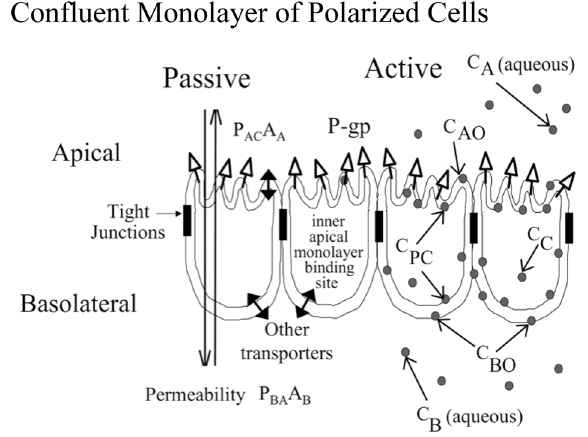
Figure 1. Model of a confluent cell monolayer, with the apical membrane on top and the basolateral membrane below, where it binds to the polycarbonate insert. Passive permeability occurs in both directions. P-gp expressed on the apical membrane transports substrate from the inner apical membrane monolayer into the apical chamber. The concentration of substrate in the apical and basolateral chambers, C A and C B , are measured, while the concentration of substrate in the inner plasma membrane, C PC , and the cytosol, C C , are predicted as part of the mass action modeling and data fitting process.